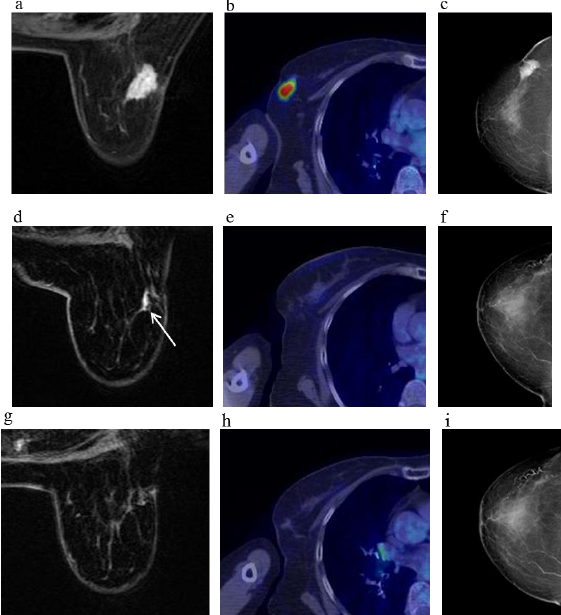
Figure 3. A 81-year-old female (case 7 in Tables 1-3) with right breast cancer (cT2N1M0). CE breast MRI, PET-CT and mammography revealed a breast tumor before KORTUC II therapy, the region of tumor was 25 mm in large diameter ( a – c ); At the initial examination after the completion of KORTUC II treatment, the tumor was undetectable on PET-CT and mammography ( e , f ); On the other hand, the residual tumor was still recognized on breast CE MRI (( d ): arrows). However, complete response was eventually achieved and no recurrence was identified on final examinations of all of these three diagnostic modalities ( g – i ).